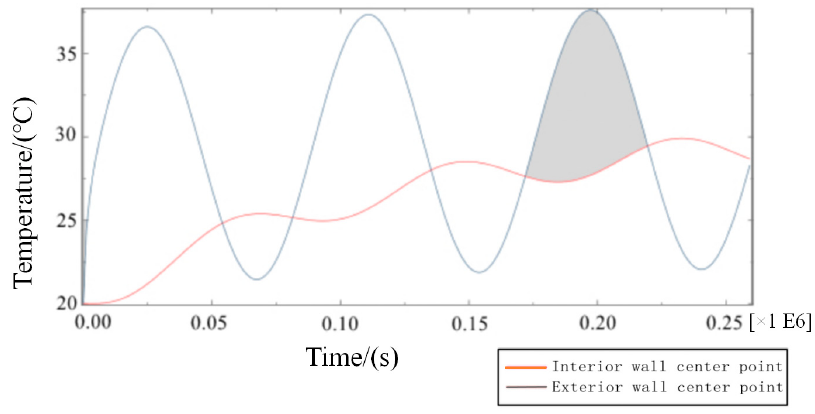
Figure 10. Transient heat transfer characteristic curve of internal and external wall temperature (high temperature).